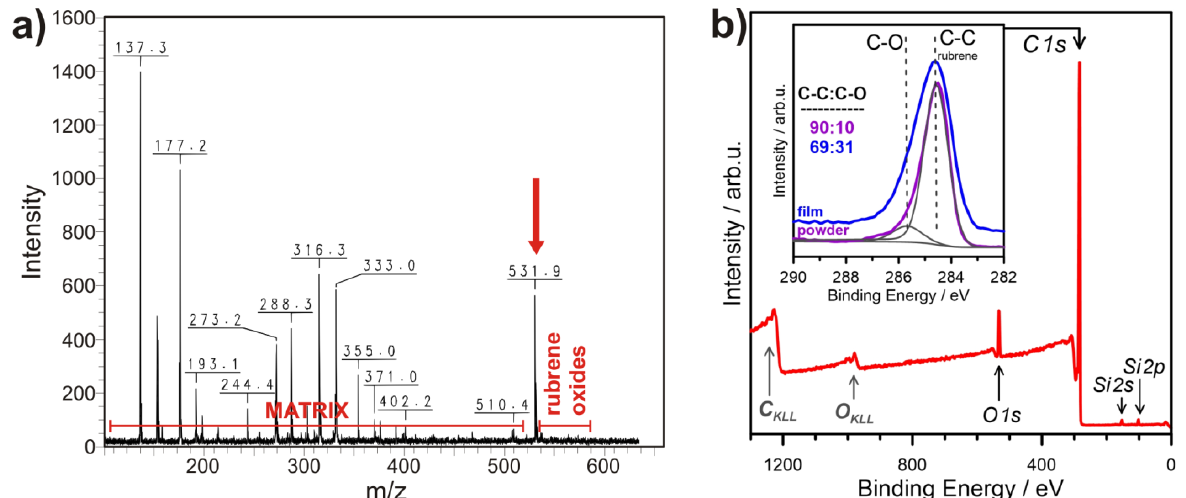
Figure 5. ( a ) MALDI spectrum showing a prominent rubrene peak at m = 531.9 confirms negligible material decomposition; ( b ) XPS survey spectrum of rubrene on glass substrate, and high-resolution C 1s spectra recorded for rubrene powder and MAPLE film (inset).